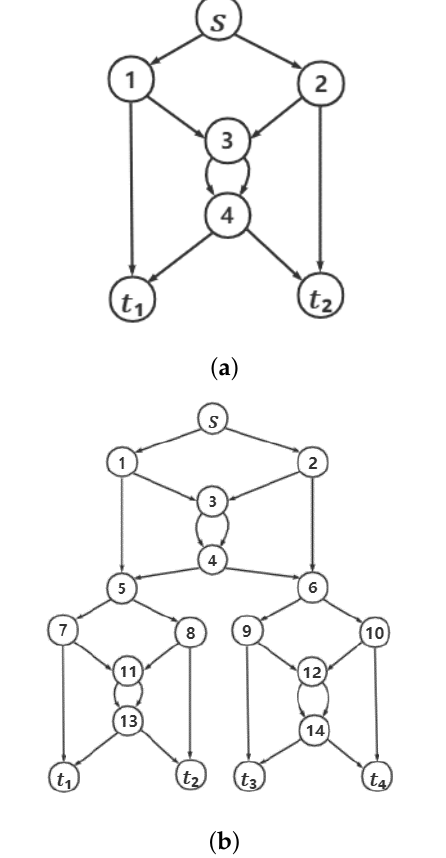
Figure 9. Explanation of n -copy networks. ( a ) Initial network; ( b ) 3-copy network. The parameters of four n -copy networks are shown in Table 4 including the number of nodes, number of sides, number of destination nodes, number of potential coding nodes, number of individual chromosome bits, maximum number of coding operations, and number of all the possible coding operations. Table 4. Parameters of